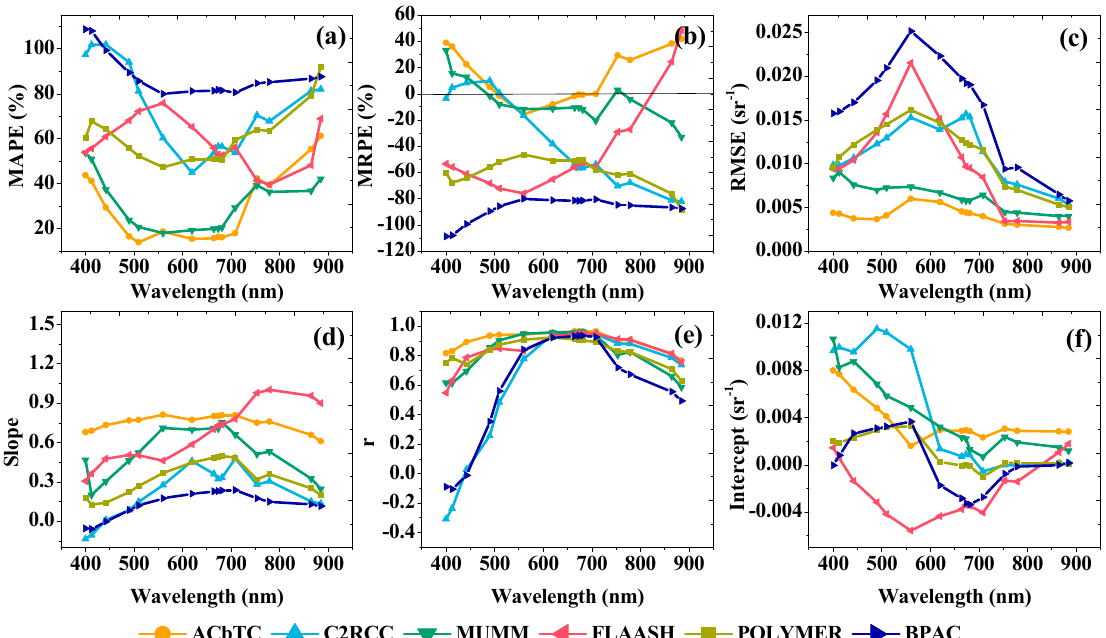
Figure 10. Comparison of ACbTC with the C2RCC, FLAASH, MUMM, POLYMER, and BPAC atmospheric correction algorithms in MAPE, MRPE, RMSE, slope, r, and intercept ( N = 72).